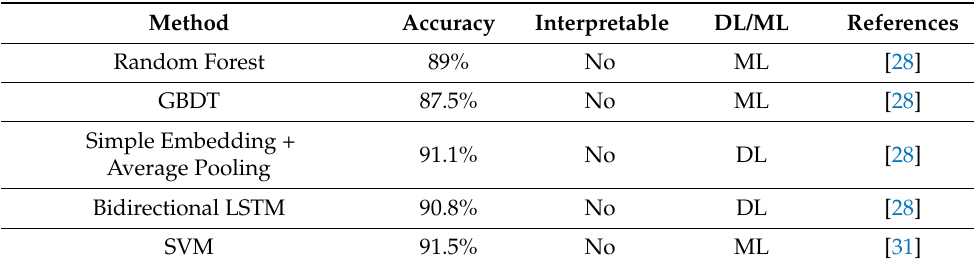
Table 3. Accuracy scores achieved in ML/DL models from recent